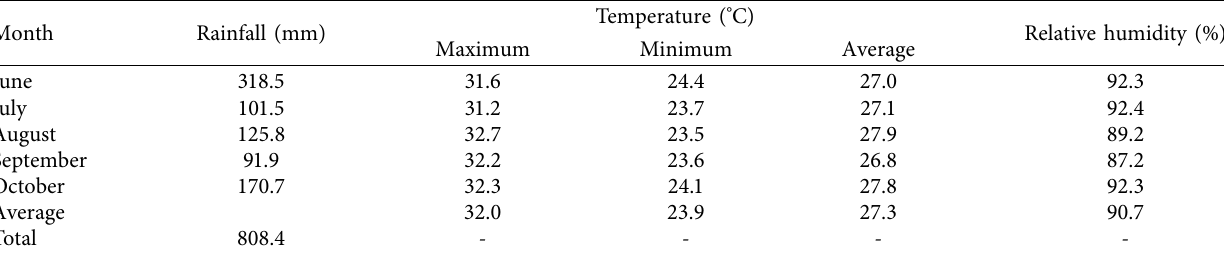
Table 2: Monthly rainfall and air temperature during the experiment in 2020.